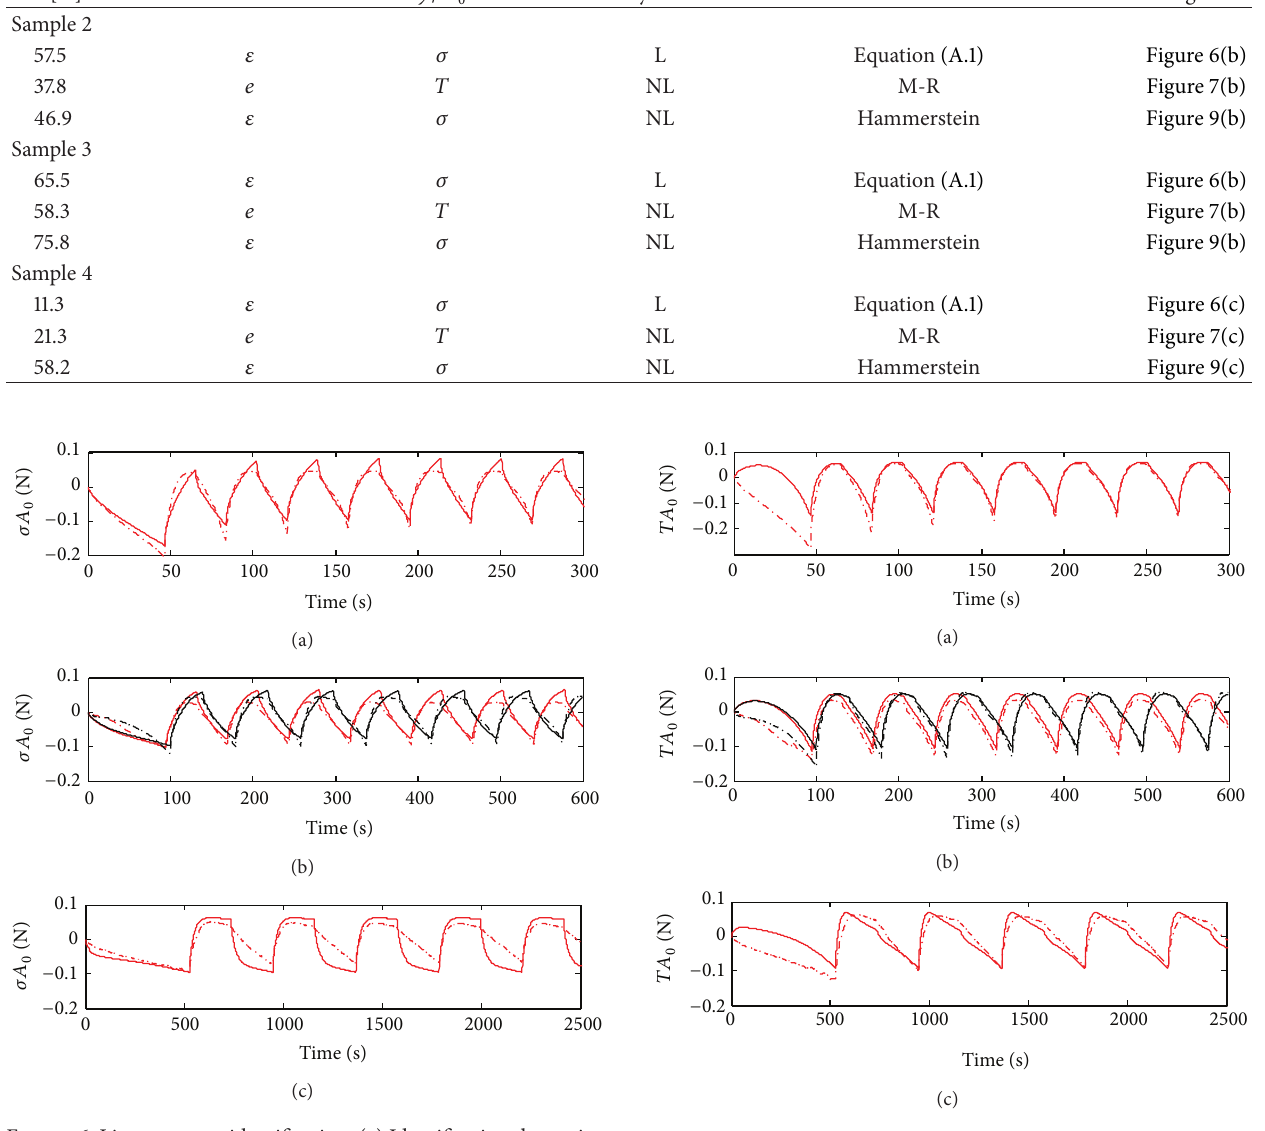
Figure 7: Grey box nonlinear system identification using Mooney- Rivlin inspired model (model 1 with structure given by (7)). (a) Identification data. Measured and estimated data are shown in dashed-dotted and continuous red line, respectively. Validation data of sample 2 (red) and sample 3 (black) are shown in (b), with the same lines code. (c) shows the validation data of sample 4.